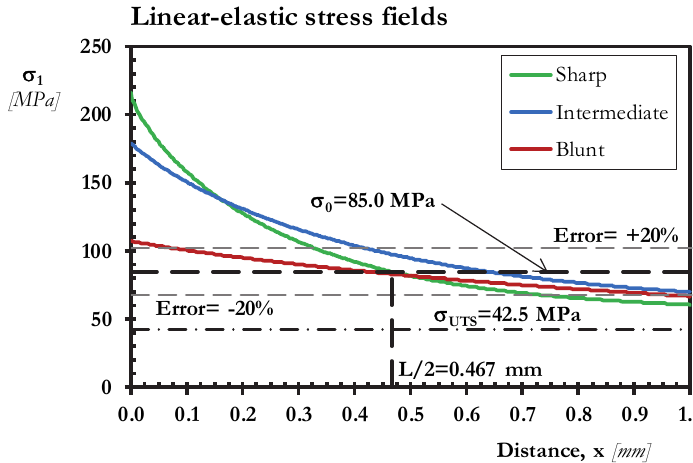
Figure 5: Linear-elastic stress fields in the incipient failure condition and determination of critical distance L.